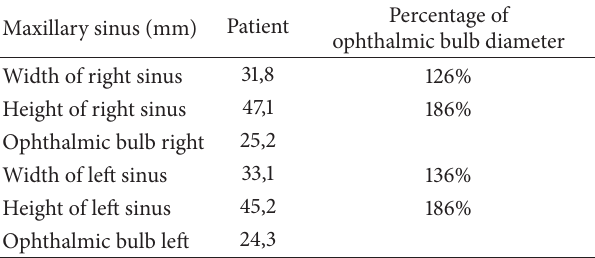
Table 3: Linear measurements (mm) of maxillary sinuses and comparison with the diameter of ophthalmic